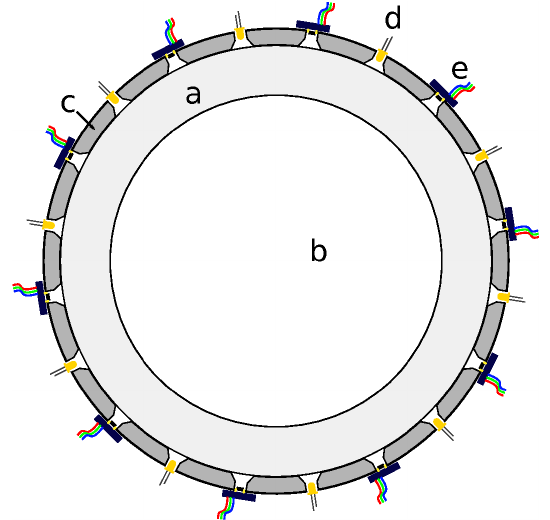
Figure 1. Schematic set-up of the measurement device. The image Fig. 1. Schematic set-up of the measurement device. The image shows a cross section of the perspex shows a cross section of the perspex pipe (a) filled with water (b) . A pipe (a) filled with water (b). A tightly fitting PVC ring (c) is fitted around the pipe. Tapered holes have tightly fitting PVC ring (c) is fitted around the pipe. Tapered holes been drilled in this ring, into which alternating LEDs (d) and light sensors (e) have been placed. have been drilled in this ring, into which alternating LEDs (d) and figure light sensors (e) have been